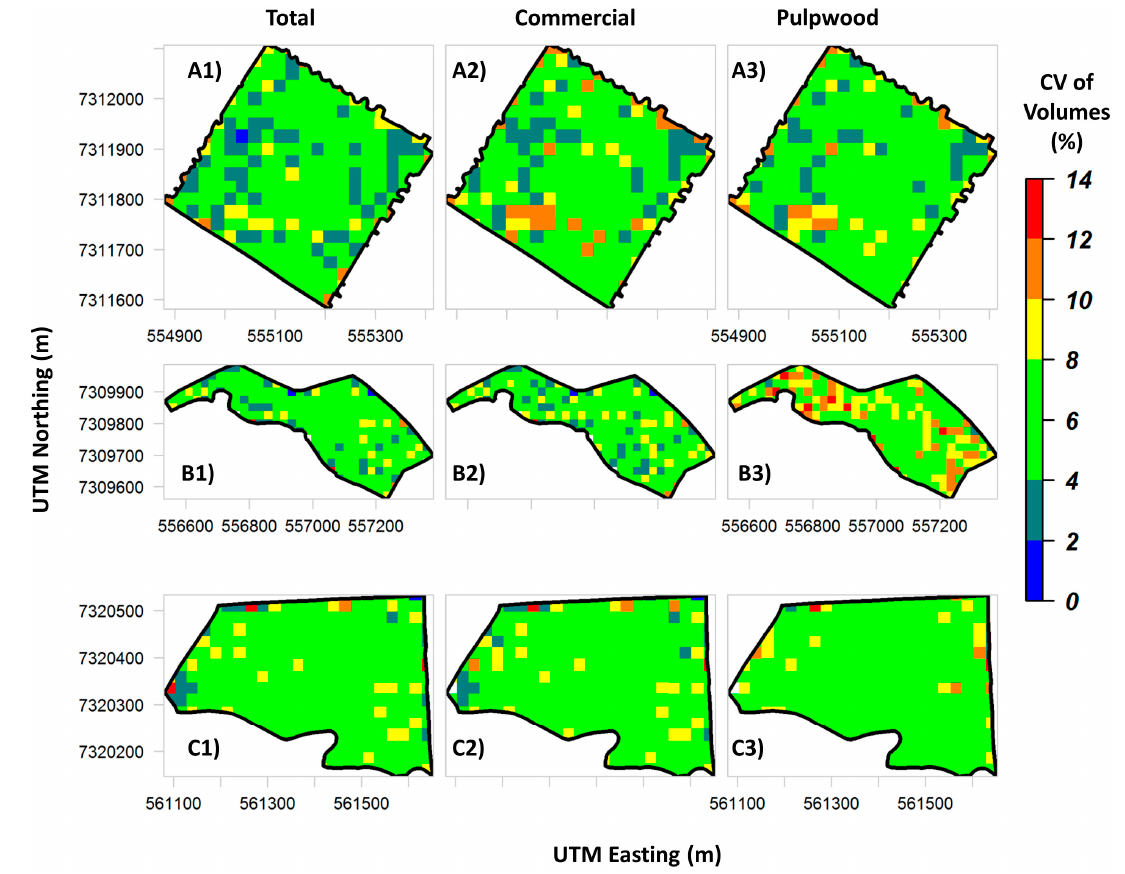
Figure 8. Coefficient of variation (CV) maps in percentage (%) of Vt ( A1 – C1 ), Vc ( A2 – C2 ) and Vp ( A3 – C3 ) of P. taeda at stand-level obtained from the 500 RF bootstrapped runs. Representative stand of